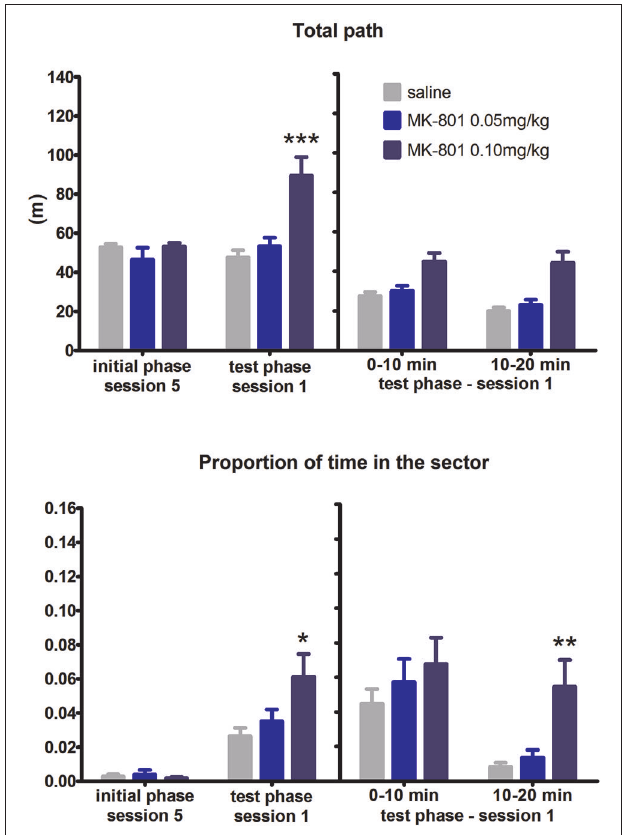
FIGURE 5 | Performance of the rats in condition 4 (set shifting: RF to AF switch) . Upper graph indicates total path elapsed during the last session of the initial phase, first session of the test phase, and its split into two 10 min segments (group means ± SEM). Lower graph shows proportion of session time spent in the prohibited sector. Difference between the session 1 of the test phase and the session 5 of the initial phase were computed as difference scores and the resulting statistics is provided. * P < 0.05, ** P < 0.01, *** P < 0.001 compared to saline